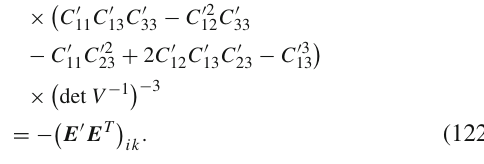
addition, the relative efficiencies (i.e. the ratios of variances) of the cFit estimator and the weighted estimator defined by Eq. 3 are